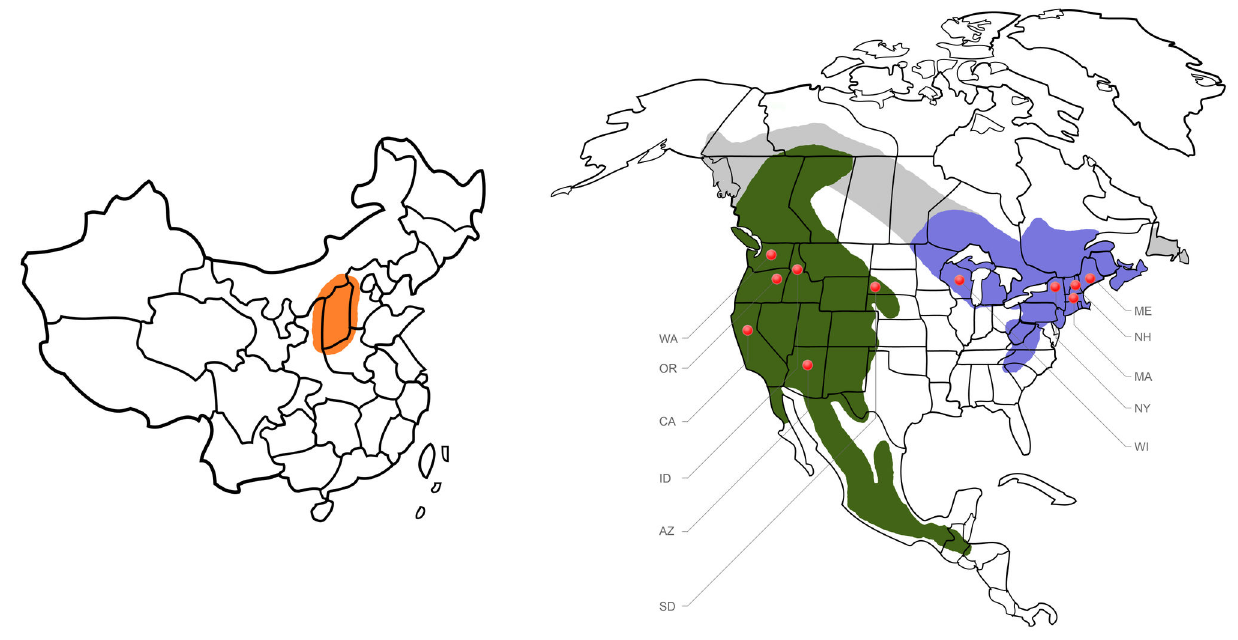
Figure 1. Ranges of Dendroctonus valens and study collection locations. Ranges of D. valens in China (orange), western North America (green) and eastern North America (blue), based on Yan et al. [50] and Wood et al. [28]. The potential range of D. valens is shaded grey (based on Owen et al. [49]). Collection locations in North America are indicated by red dots. State names are as follows: AZ = Arizona, CA = California, ID = Idaho, ME = Maine, MA = Massachusetts, NH = New Hampshire, NY = New York, OR = Oregon, SD = South Dakota, WA = Washington, and WI =